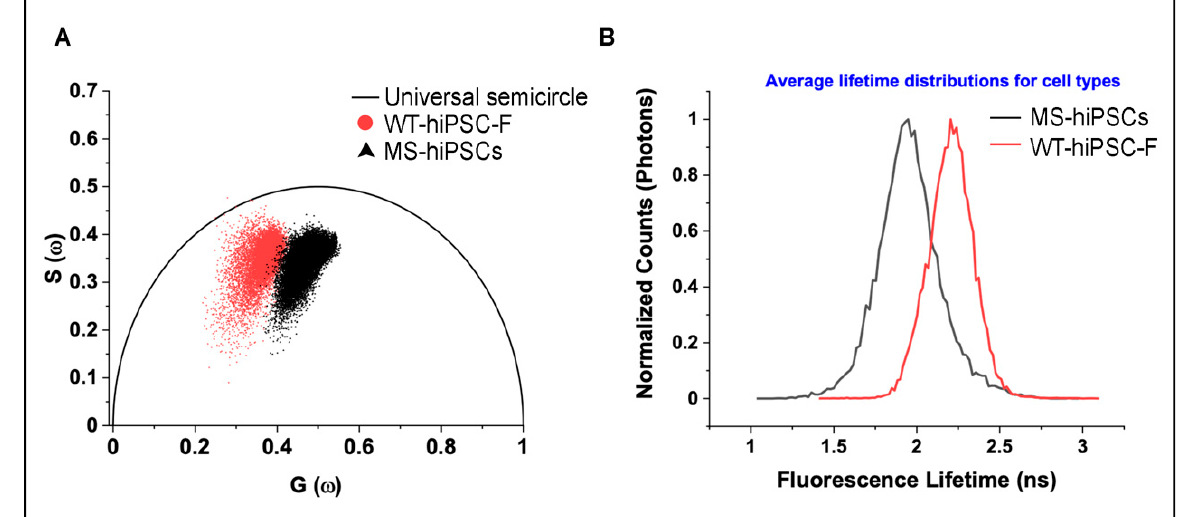
Figure 8. Two-photon fluorescence lifetime imaging microscopy (2P-FLIM) of MS-hiPSCs and WT-hiPSC-F . ( A ): Phasor plot of intrinsic fluorescence of MS-iPSCs compared to WT-hiPSC-F (normal control). ( B ): Average lifetime distributions for MS iPSCs and NKL5.